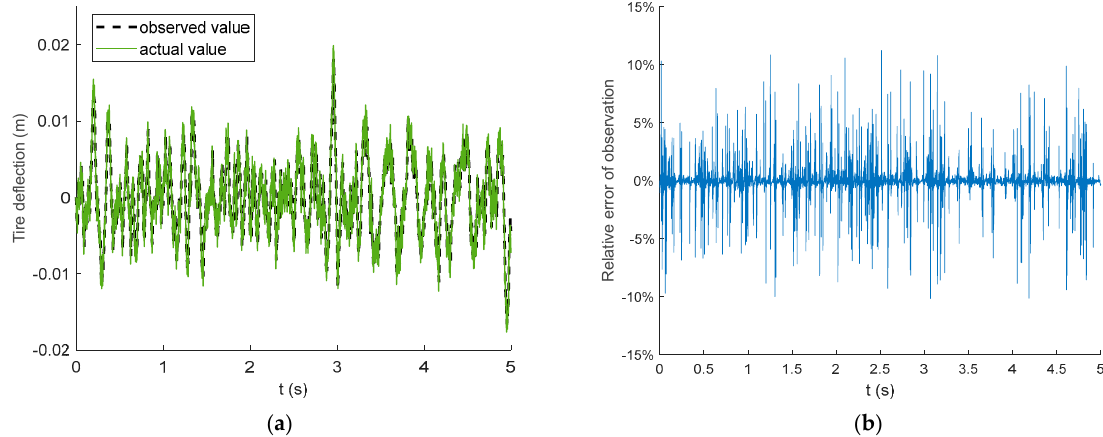
Figure 11. Observed results of tire deflection. ( a ) Comparison of observed and actual values. ( b ) Relative error between observed and actual values. Under the disturbance of grey noise, the observer results under C-class road excita- tion are shown in the figure below.